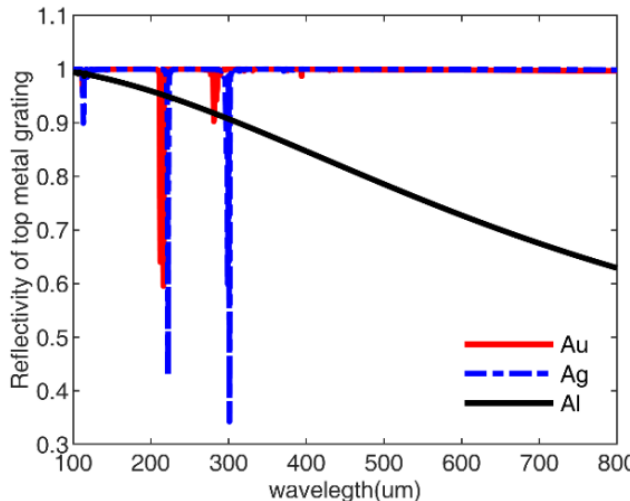
Figure 13. Reflectivity of the top grating under different metal.